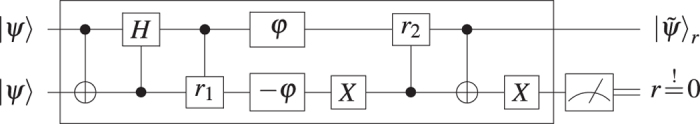
A quantum circuit implementing Mandelbrot maps.The controlled gate labelled by the real number rj is essentially a rotation composed with a Pauli-Z-gate  and the gate labelled by ±φ is a phase gate , while H and X stand for the Hadamard and Pauli-X gates correspondingly. If we set r1 = 1/r2,  and , then the resulting map is z2 + c, provided that we accept only the 0 measurement outcome on the second qubit.